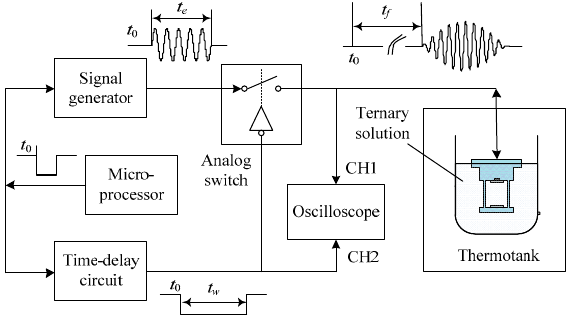
Figure 3. Schematic diagram of TOF measurement.